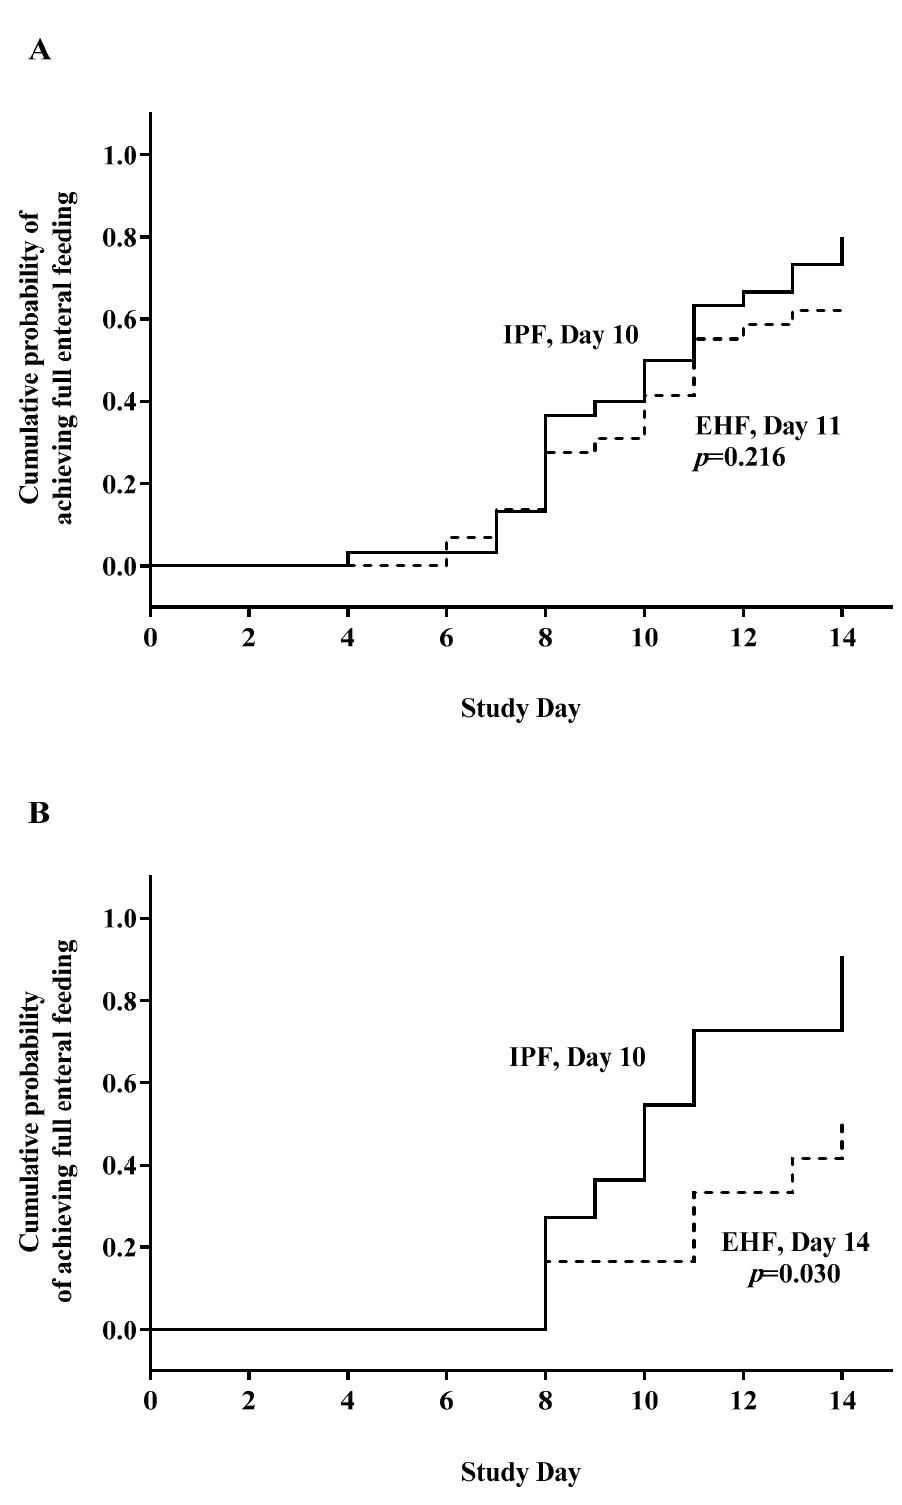
Figure 2. Days to full enteral feeding ( ≥ 140 mL/kg/day): ( A ) No significant difference for the intact protein preterm formula (IPF) vs. extensively hydrolyzed formula (EHF) group for all who met study entrance criteria and completed study feeding (day 10 vs. 11; p = 0.216). ( B ) Subset analysis: significantly shorter for the IPF vs. EHF group for participants receiving ≥ 75% enteral intake from study formula intake (day 10 vs. 14; p = 0.030).